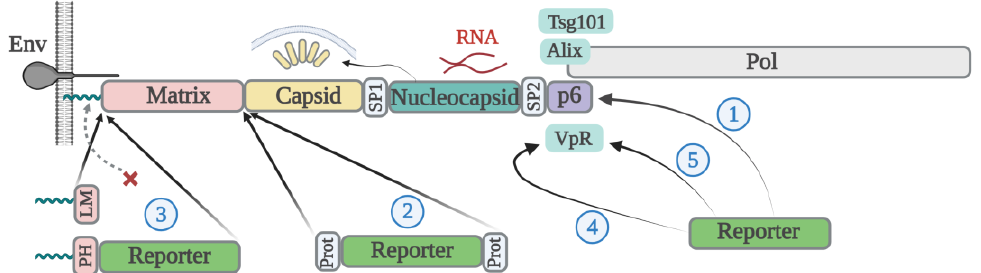
Figure 1. A simplified illustration schematically showing the function of each structural domain of HIV Gag (on top) and the approaches (1 – 5) used for reporter protein incorporation into viral particles (beneath). Each approach was described in the following references: 1—[25–27], 2—[29–31], 3—[34–36], 4—[39,41], and 5—[40], see main text. Myristate modification (shown by spirals) driven by signals from Lyn kinase (LM), or the phospholipase C- δ 1 pleckstrin homology domain (PH) substitutes the matrix myristylation (shown by dashed arrow with X). Prot stands for HIV protease cleavage site. Prepared with https://app.biorender.com/illustrations/638a443e9cc25bb34b5c8f23 (accessed on 2 March